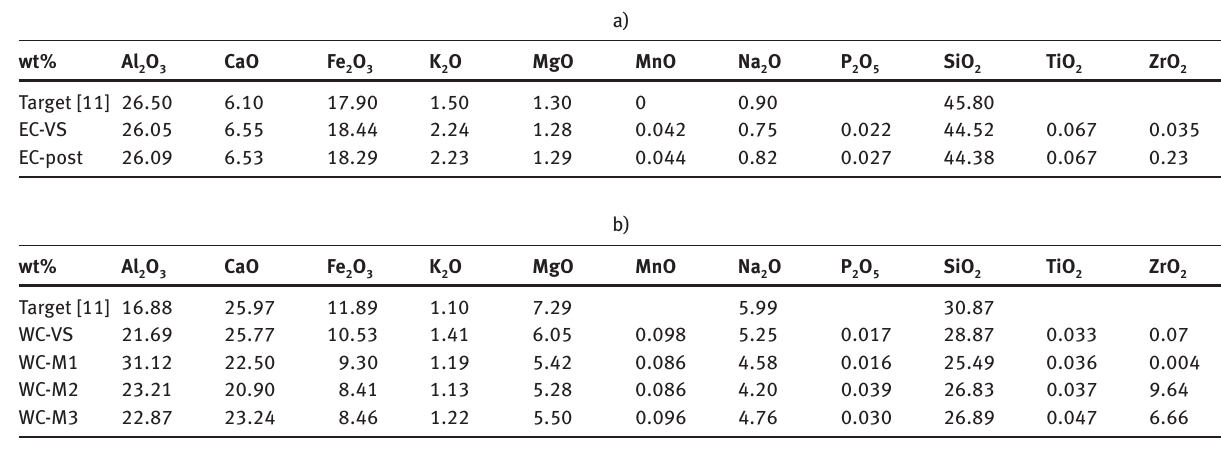
Table 1: Examples of several different U.S. coal chemistries based on geographic location. a) overall composition, and b) ash chemistry in weight percentage [2]